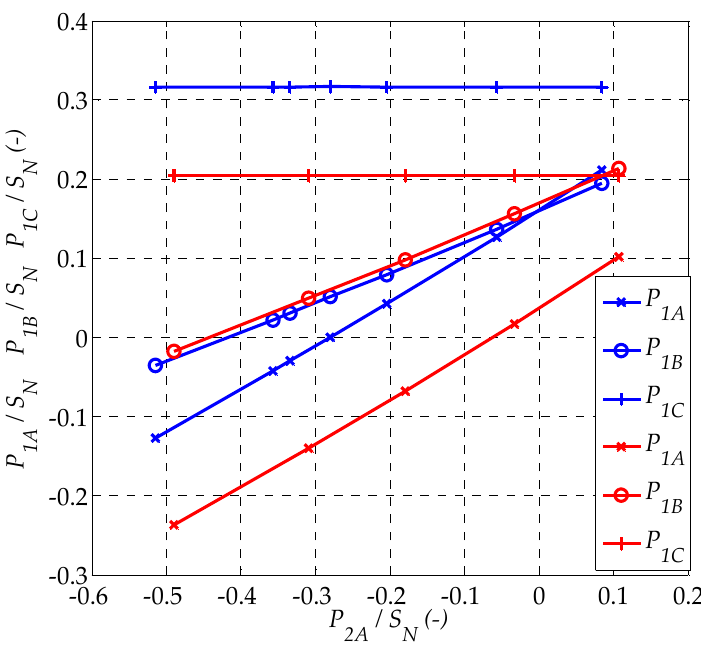
Figure 3. Active powers of the phases of the transformer’s primary side at the R or RL load of the secondary side B and C phases, as a function of the active power of the prosumer source in phase A of the secondary side, with amplitude control (blue line — R load, red line — RL load, p.f. = 0.8).